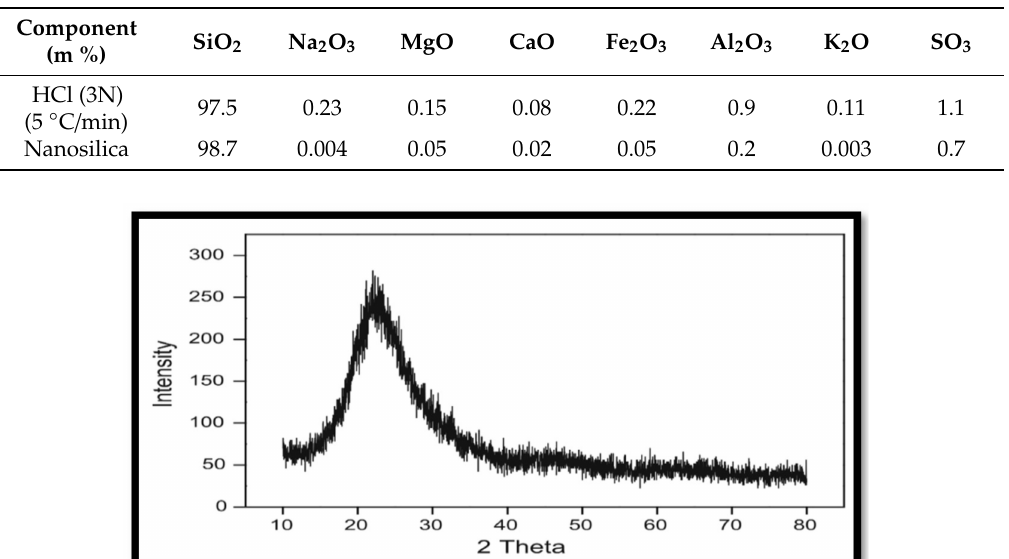
Table 2. Chemical composition of the RHA and nanosilica analyzed by XRF.